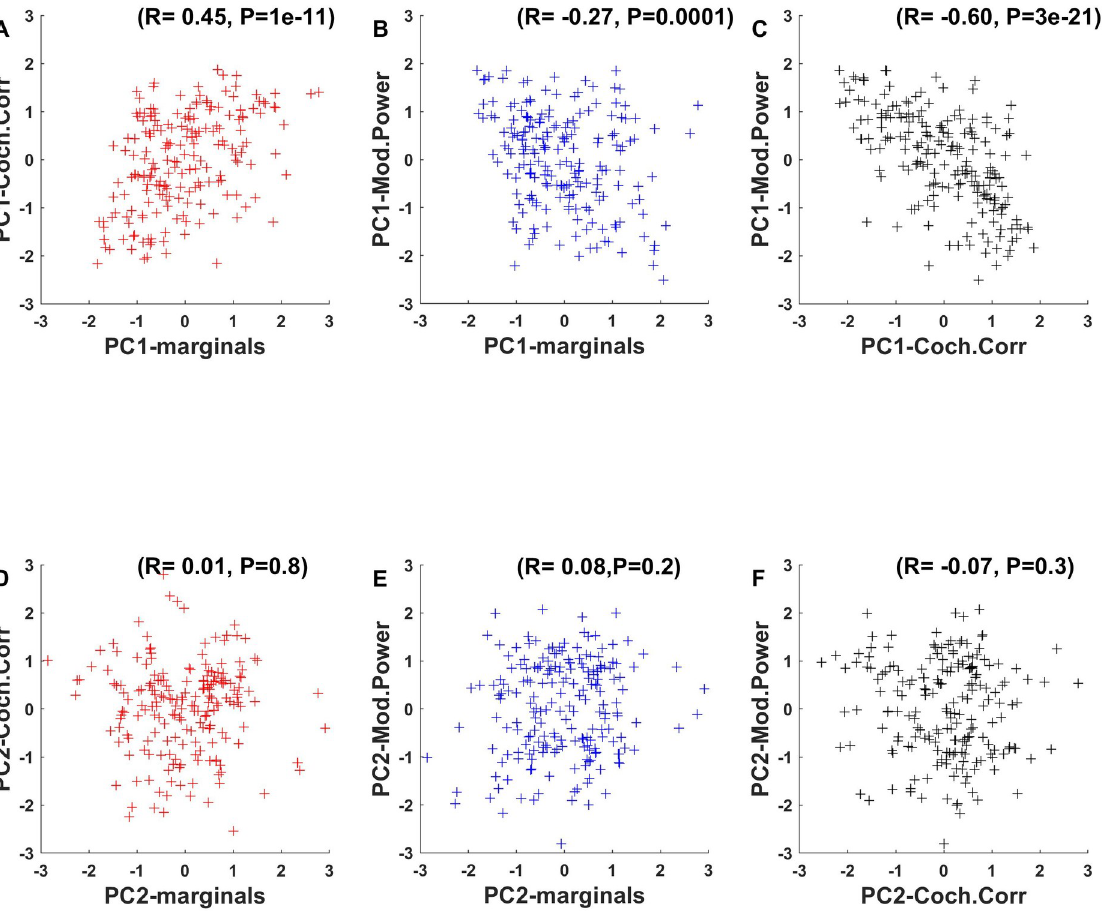
Fig 11. Correlations between principal component coordinates. Top row : (A) PC1 of cochlear correlations and marginal statistics are positively correlated (R = 0.45). (B) There is also a weak negative correlation (R = -0.27) between the PC1 of marginals and modulation power, (C) and a weak negative correlation (R = -0.6) between the PC1 of modulation power and cochlear correlation. Bottom row : (D-F) No significant pairwise correlations were observed between the PC2 coordinates marginals, cochlear correlation or modulation power.